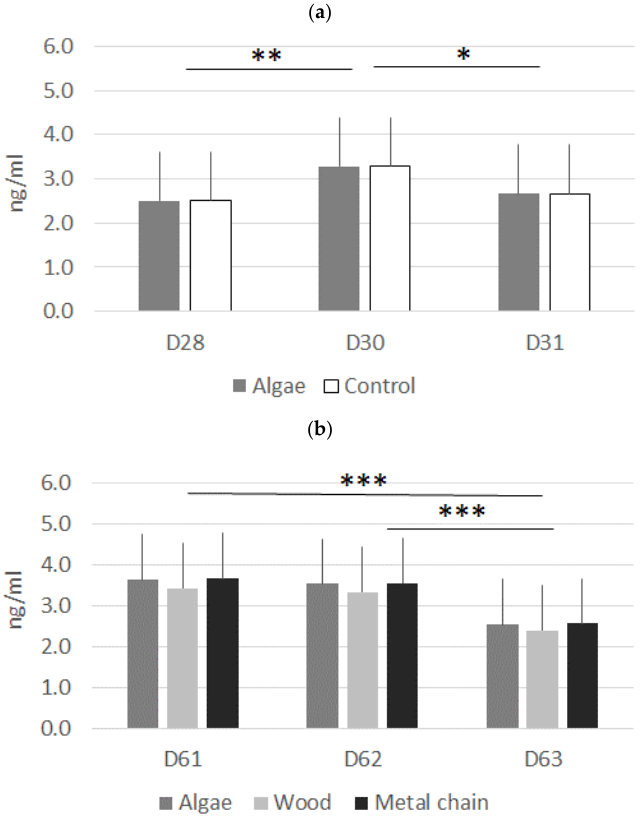
Figure 2. Cortisol concentration in pig saliva according to the enrichment material provided before and after transfer ( a ) from the farrowing pens to the nursery pens (batch B2, n = 52 piglets); and ( b ) from the post-weaning pens to the finishing pens (batch B1, n = 156 pigs). Results are shown as least square means ± standard error. A mixed ANOVA model with the pen as random effect was used to compare cortisol levels (* means p < 0.1; ** means p < 0.01; and *** means p < 0.001).